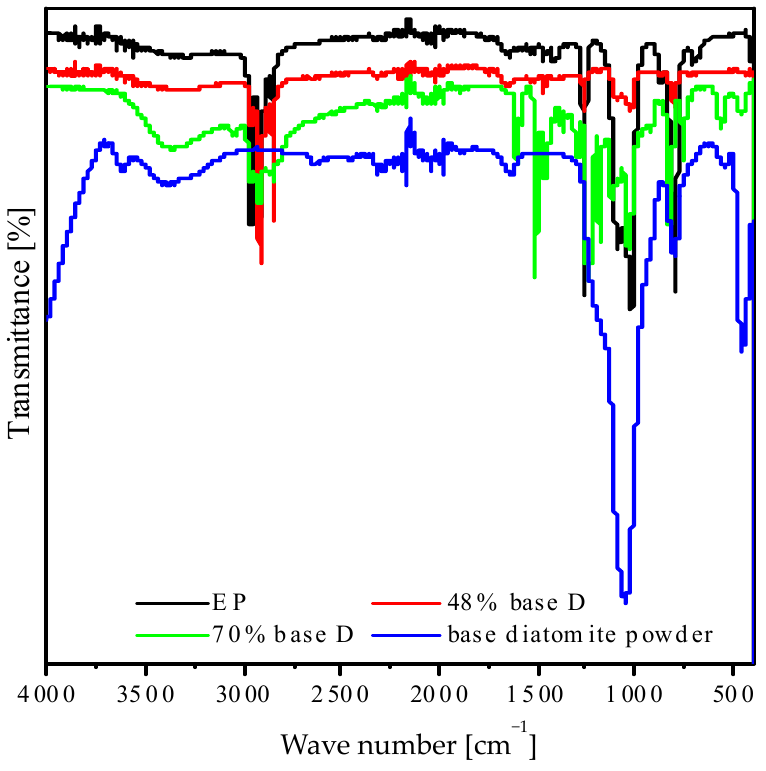
Figure 12. FT-IR spectra of degassed composites containing base diatoms and base diatomite powder. Base D: base diatomite. EP: neat epoxy resin.